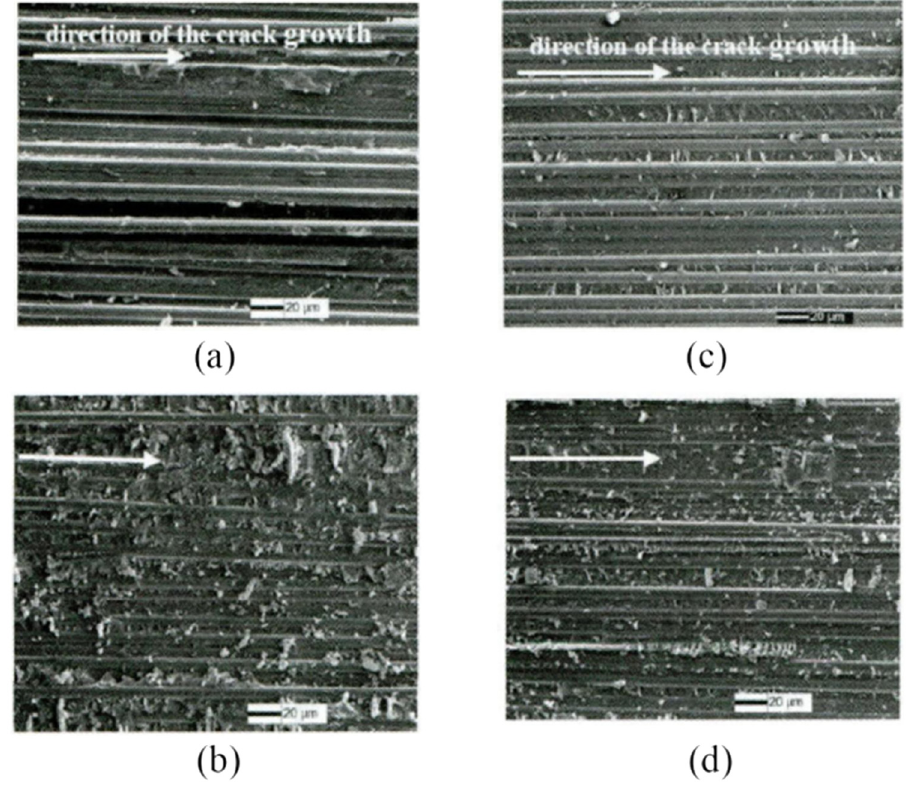
Figure 15: Fracture morphology of CFRP laminates before and after adding CNTs random fi lm: ( 1 ) the G IC morphology of sample with ( b ) and